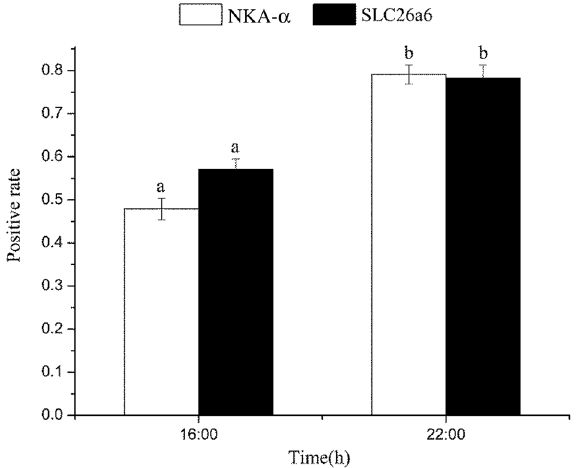
Figure 4. NKA-α, SLC26A6 positivity rate in the mid-intestine of Gymnocypris przewalskii at different time points exposed to saline-alkaline lake water with a salinity of 17 (L17). Light–dark cycle was 14:10-h light:dark (5:00–19:00 with light intensity of 600–1000 lx;19:00–5:00 with light intensity of 0 lx); Lowercase indicates significant difference among time points in each treatment ( P < 0.05); Positive rate = protein staining/nuclear staining. Image J was used for measurement, analysis and